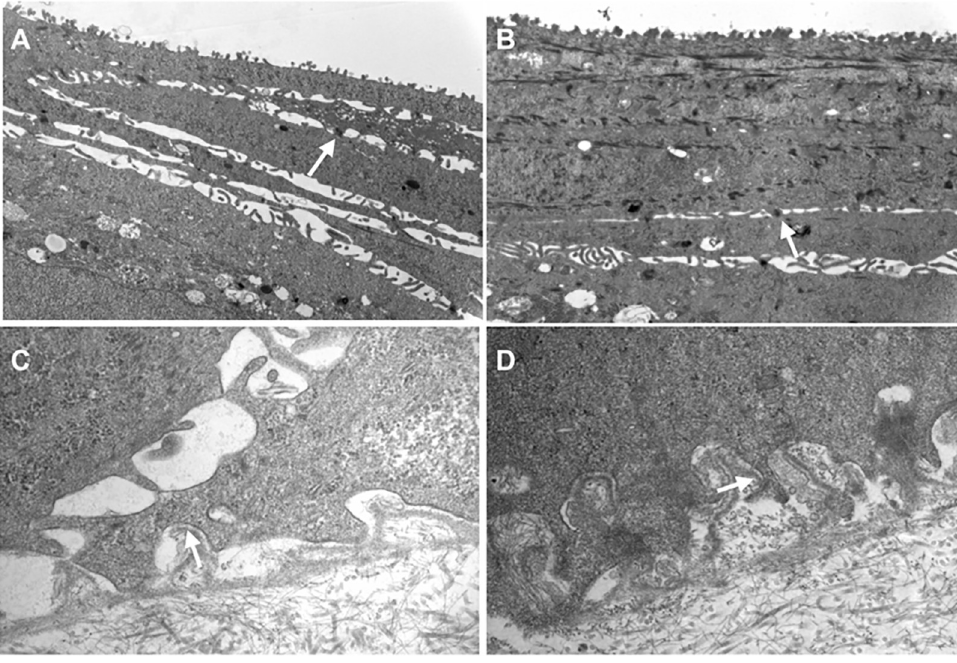
Fig 5. Ultrastructure of human LEC derived from small and large explants. Transmission electron microscopy showing desmosomes (A and B) and hemidesmosomes (C and D) of cultured cells derived from large (A and C) and small (B and D) human explants. White arrows indicate these structures.